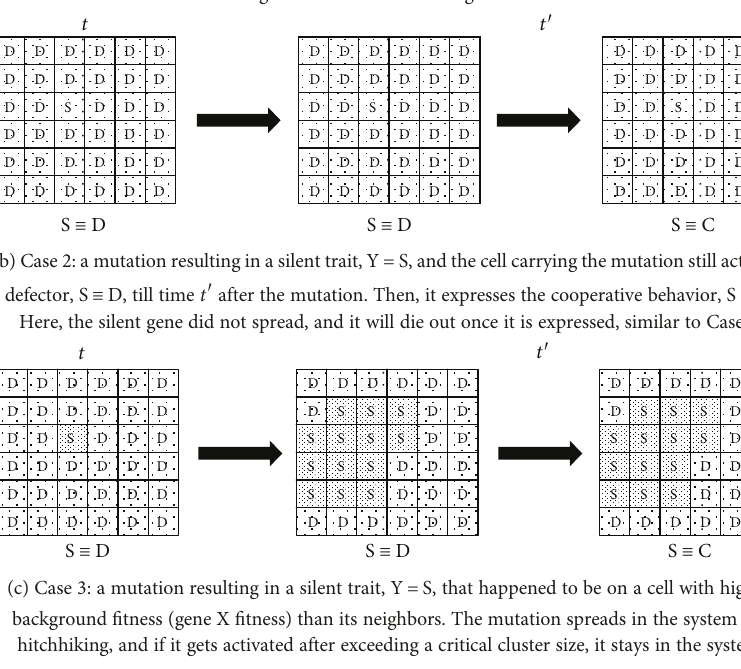
Figure 14: An illustration of the di ff erent scenarios for emergence of a cooperative behavior in a world of defectors in the model. The dot density here represents the background fi tness (gene X fi tness) of a cell.